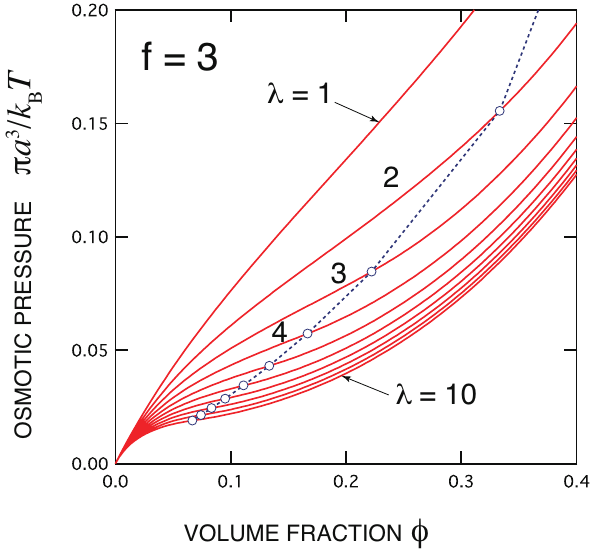
Figure 1. The osmotic pressure π a 3 / k B T plotted against the volume fraction of the primary molecules of low molecular weight ( n = 1). The functionality of the molecule is fixed at f = 3. The association constant λ is varied from curve to curve. The gel points are indicated by circles.